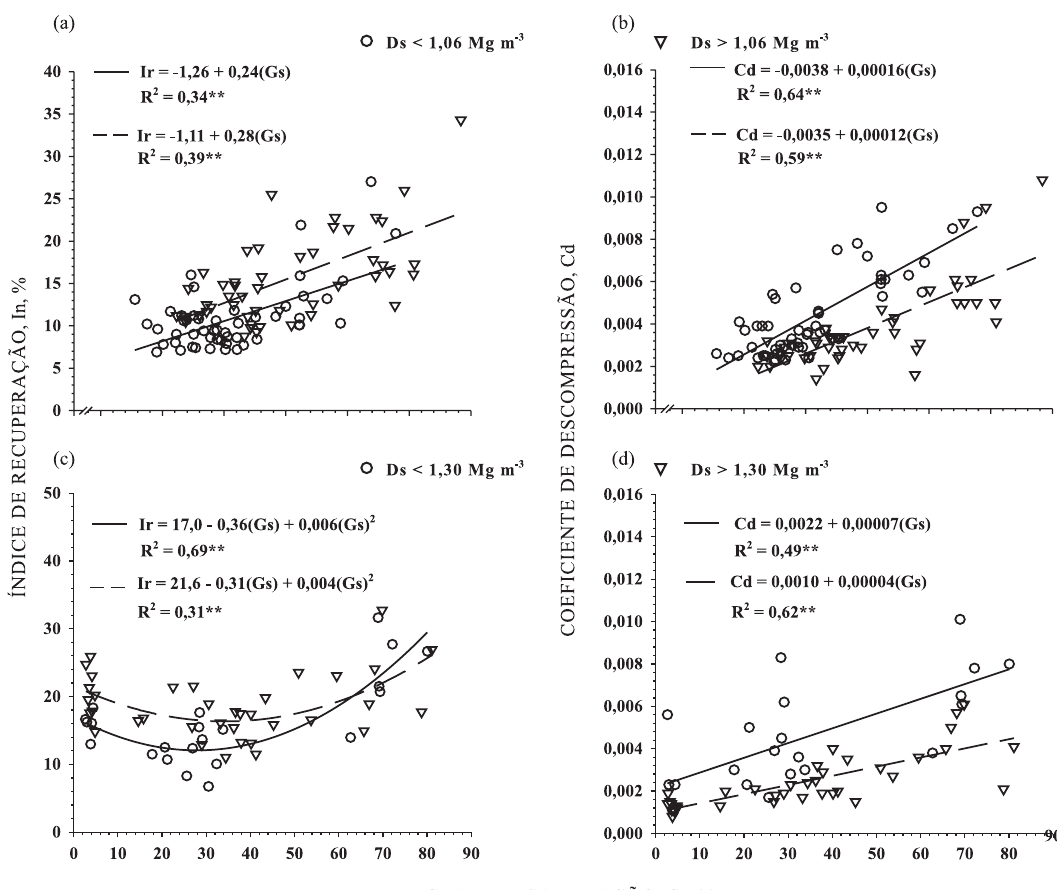
2. Índice de recuperação e coeficiente de descompressão de um Nitossolo Vermelho distrófico latossólico (a) e (b), respectivamente) e de um Argissolo Vermelho-Amarelo distrófico arênico (c) e (d), respectivamente), em função da densidade e do grau de saturação com água do